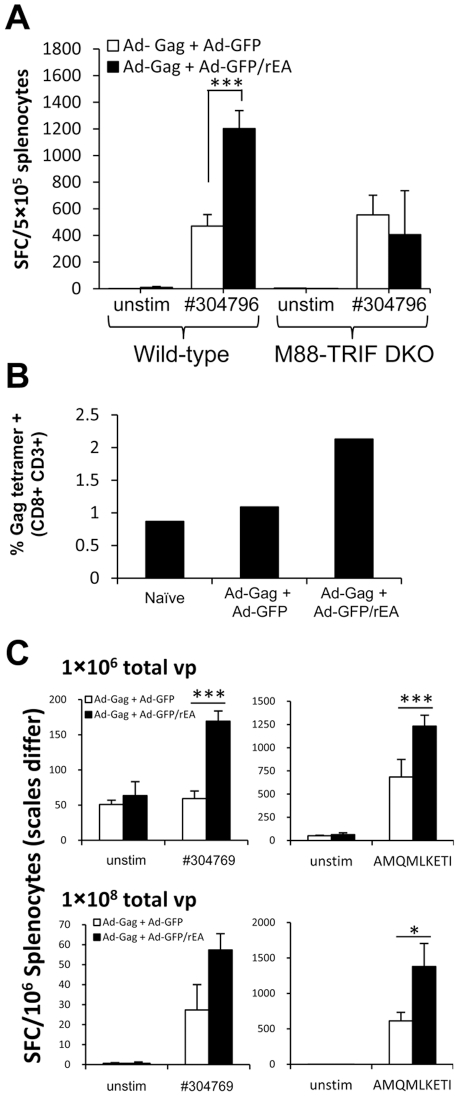
Increased HIV-Gag specific CMI responses in mice co-injected with Ad-GFP/rEA.(A) Wild-type (N = 3) or MyD88/TRIF double knockout (M88-TRIF DKO; N = 3) mice were co-immunized IM with equivalent viral particles of Ad-Gag mixed with either Ad-GFP or Ad-GFP/rEA (total of 1×107 vps mixed prior to injection). At 14 dpi IFNγ ELISpot analyses were completed using QBI# 304796 to restimulate cells ex vivo. Data are presented as mean ± SE. *** denotes statistically significant difference (p<0.001). (B, C) Balb/c mice (n = 3) were co-immunized IM as above (total of 1×106 vps). At 8 dpi, Gag specific CD3+/CD8+ T-cells in PBMC preparations were analyzed by FACS. (C) At 14 dpi, splenocytes were stimulated ex vivo with the indicated peptide to complete IFNγ ELISpot analyses. Data represent the mean ± SE. *, *** represent p<0.05, p<0.001 respectively. This experiment was completed in triplicate at various doses yielding identical results (two doses are illustrated in this figure).